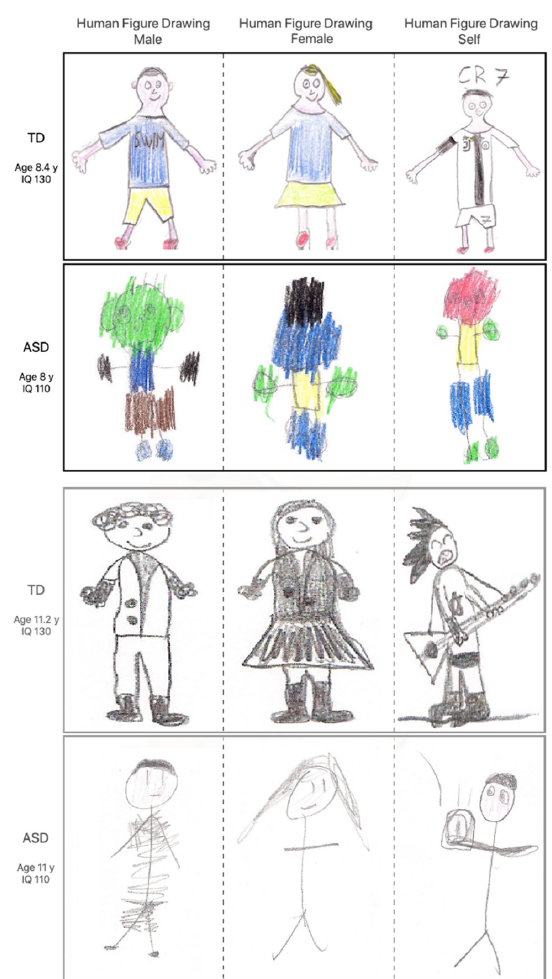
Figure 1. Examples of HFDs by ASD and TD children matched for age. Upper strips (black frame) relate to young children (8 years old), lower strips (grey frame) relate to older children in our range (11 years old). The triplets of maturity scores for the four subjects are (136.9, 125.0, 136.9), (72.4, 71.2, 76.2), (102.3, 112.1, 102.3), and (52.9, 50.1, 49.2), respectively.